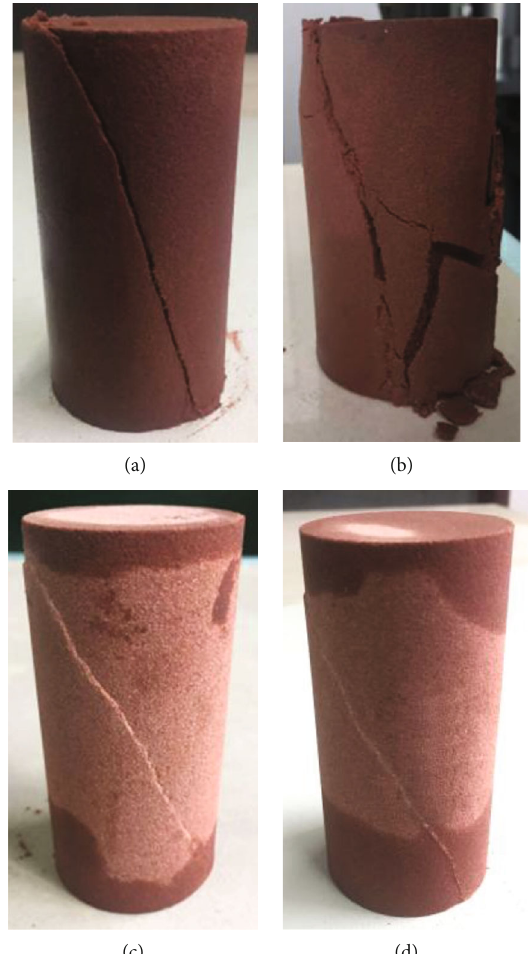
Figure 4: Macrofailures of red sandstone under di ff erent con fi ning pressures: (a) 5MPa; (b) 10MPa; (c) 15MPa; (d)